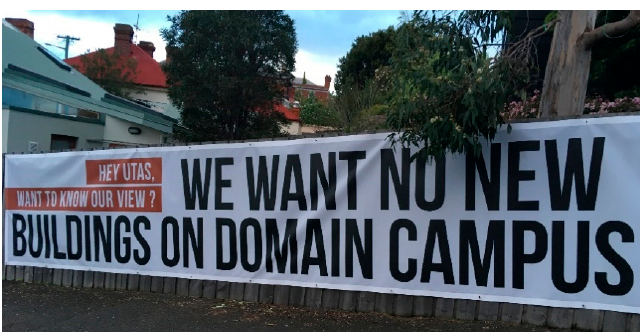
Figure 1. Inner-city residents respond to the Southern Future Strategy announcement.